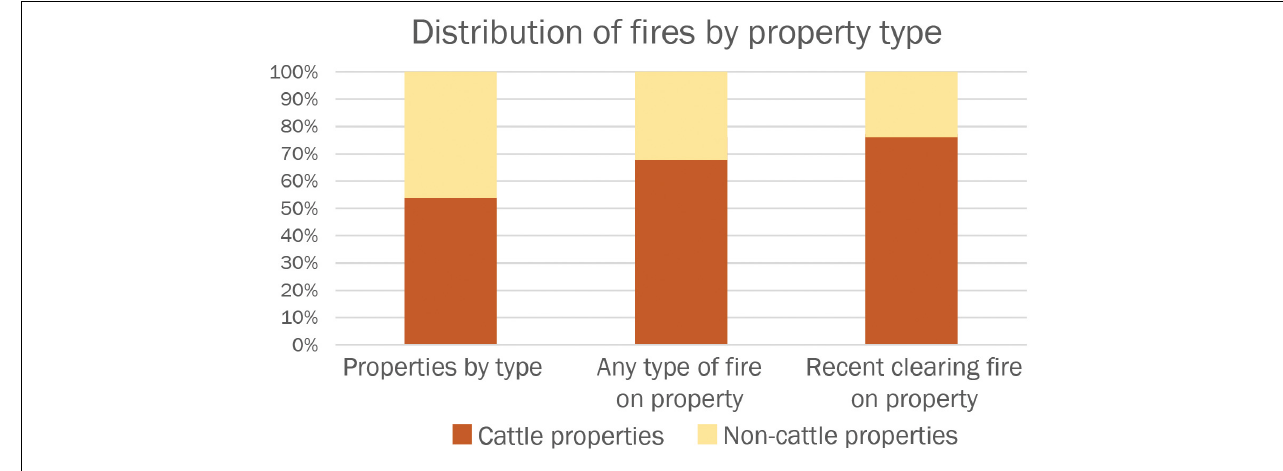
FIGURE 3 | Distribution of properties and fires by type. TABLE 1 | Proportion of cattle vs. non-cattle properties by